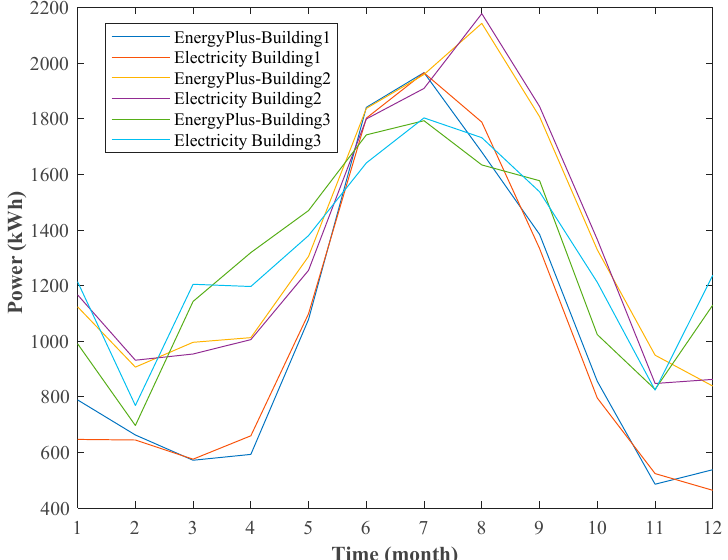
Figure 2. Comparison between simulated and monthly bill electricity usage of different buildings.